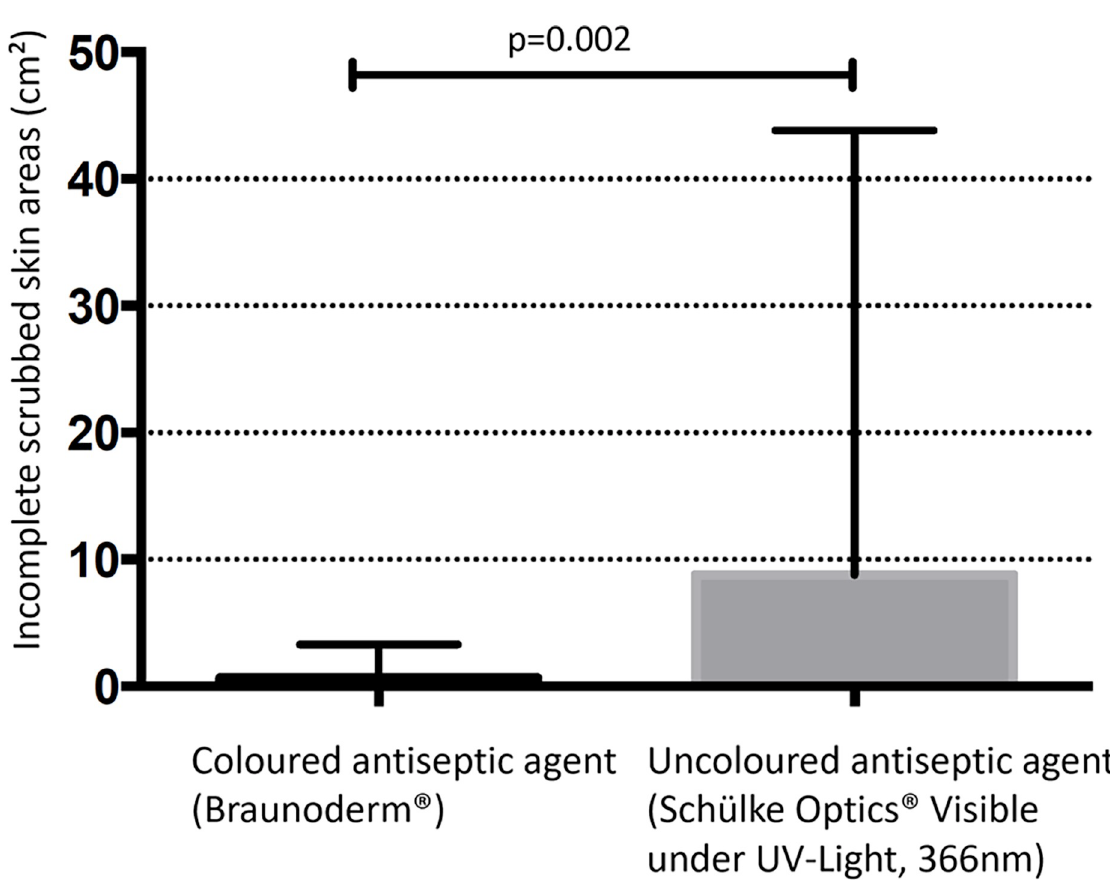
Fig 6. Graph demonstrating the difference in surface area of inadequately prepared skin (Colored antiseptic v.s. colorless antiseptic).